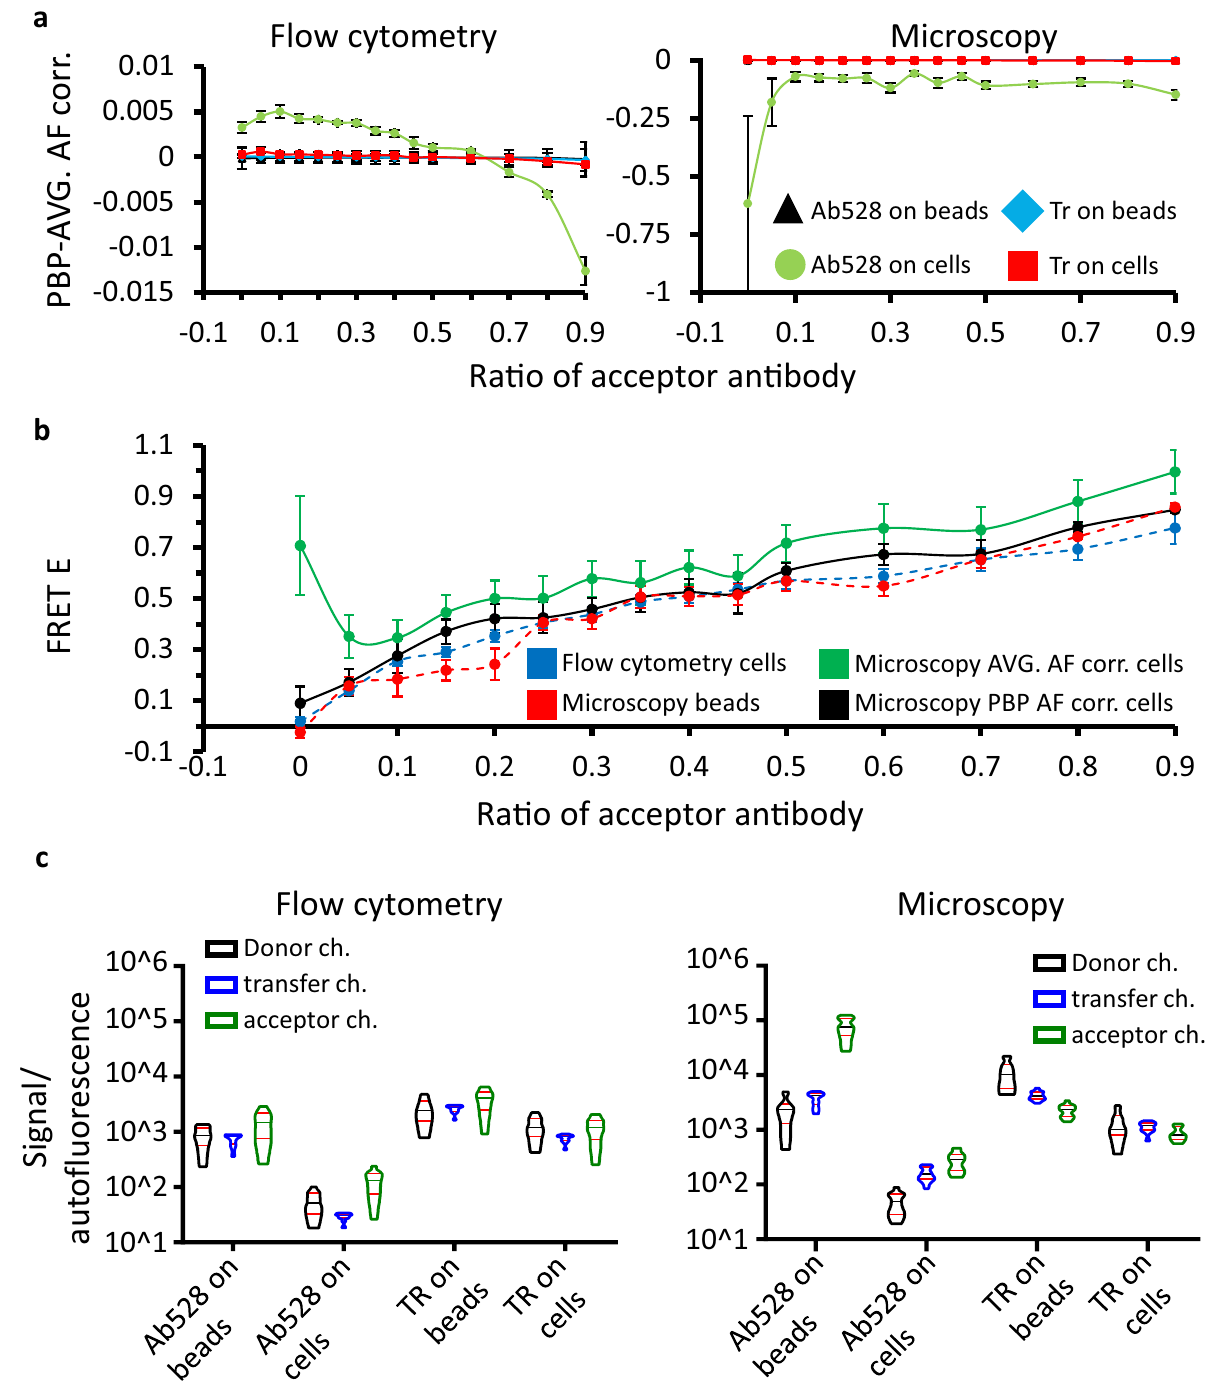
Figure 4. FRET measured on beads and cell suspensions with microscopy and flow cytometry. ( a ) Differences of the average and pixel-by-pixel autofluorescence correction, measured with flow cytometry and confocal microscopy on the control sample set. After gating, at least 1700 cells/5000 pixels remained for every plotted point. Error bars are ± SD. ( b ) FRET efficiencies measured with donor on the ab528 antibody, plotted against the ratio of acceptor-tagged antibody. ( c ) Fluorescence signals relative to autofluorescence, measured with flow cytometry and microscopy in all the FRET related channels. Data are shown on violin